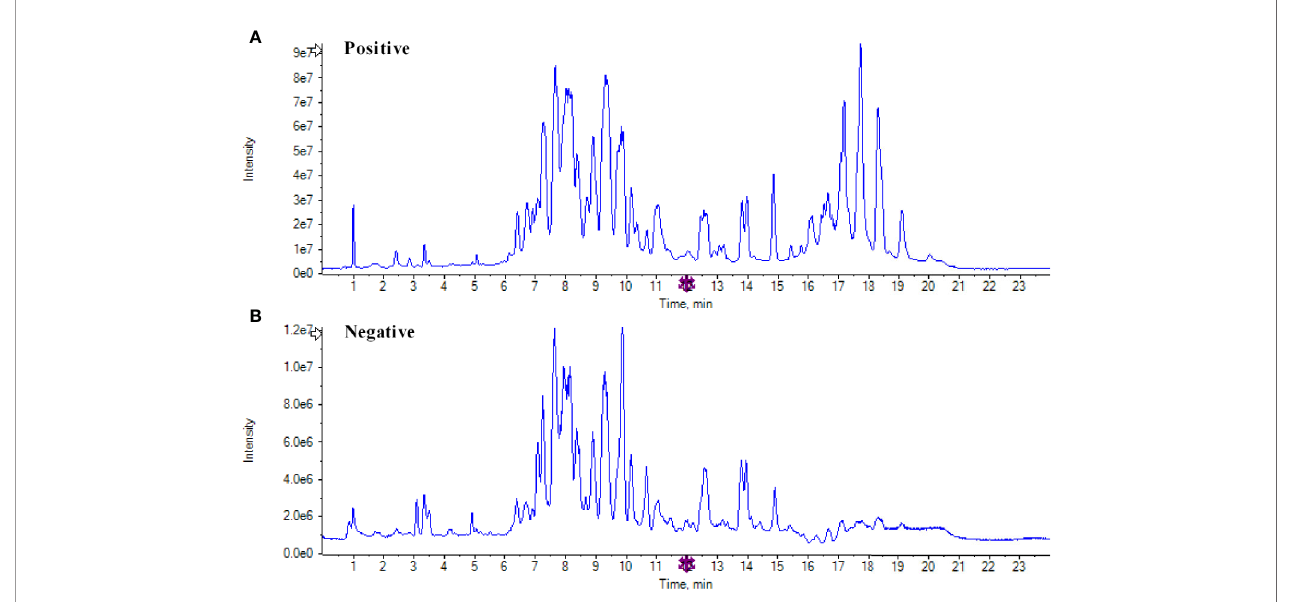
FIGURE 2 | Representative total ion chromatograms for kidney samples. (A) Total ion chromatogram of quality control (QC) samples in positive mode; (B) Total ion chromatogram of QC samples in negative